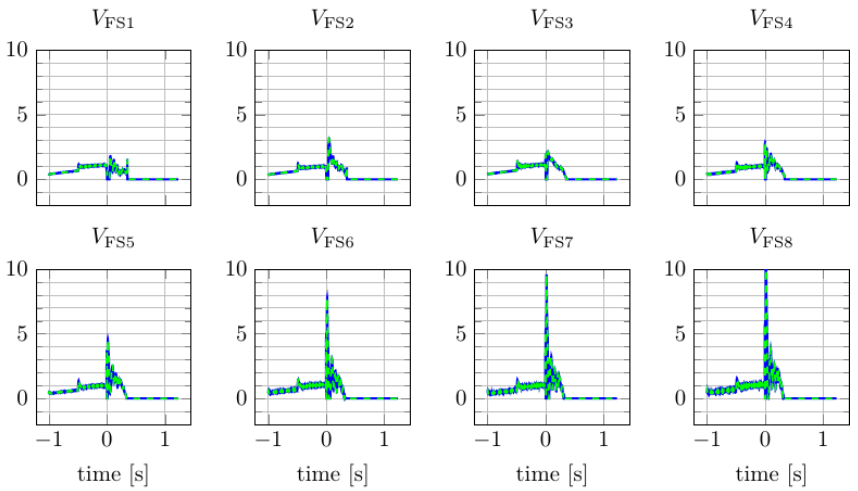
Figure 5. Voltage references of the Field Shaping Coils [V] produced by the reviewed axisymmet- ric system (dashed) obtained by feeding the system with waveforms from previous experiments compared with the experimental outputs. Voltage values are scaled to a factor of